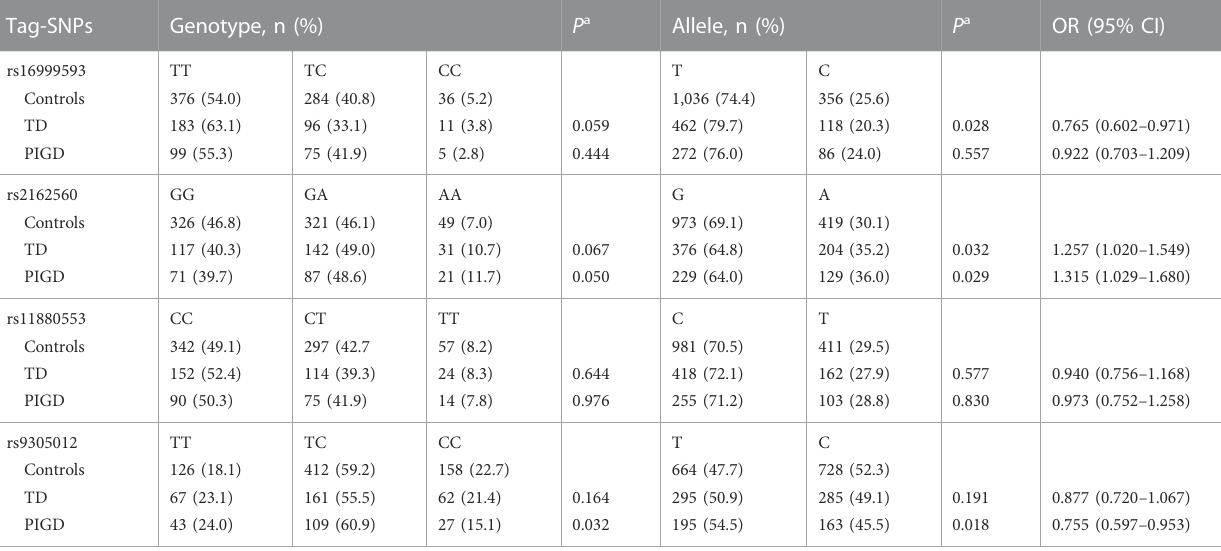
TABLE 5 Genotype and allele frequencies of DNMT1 tag-SNPs in PD subtypes. Tag-SNPs Genotype, n (%)